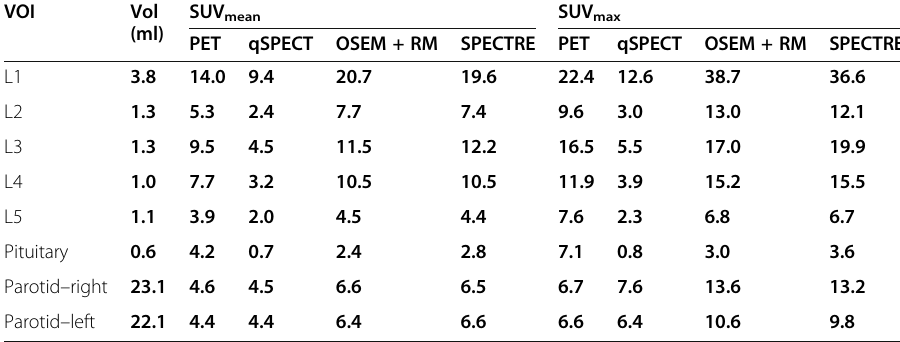
Table 2 Mean and max SUVs for VOIs within the head of the test patient VOI Vol SUV mean (ml)